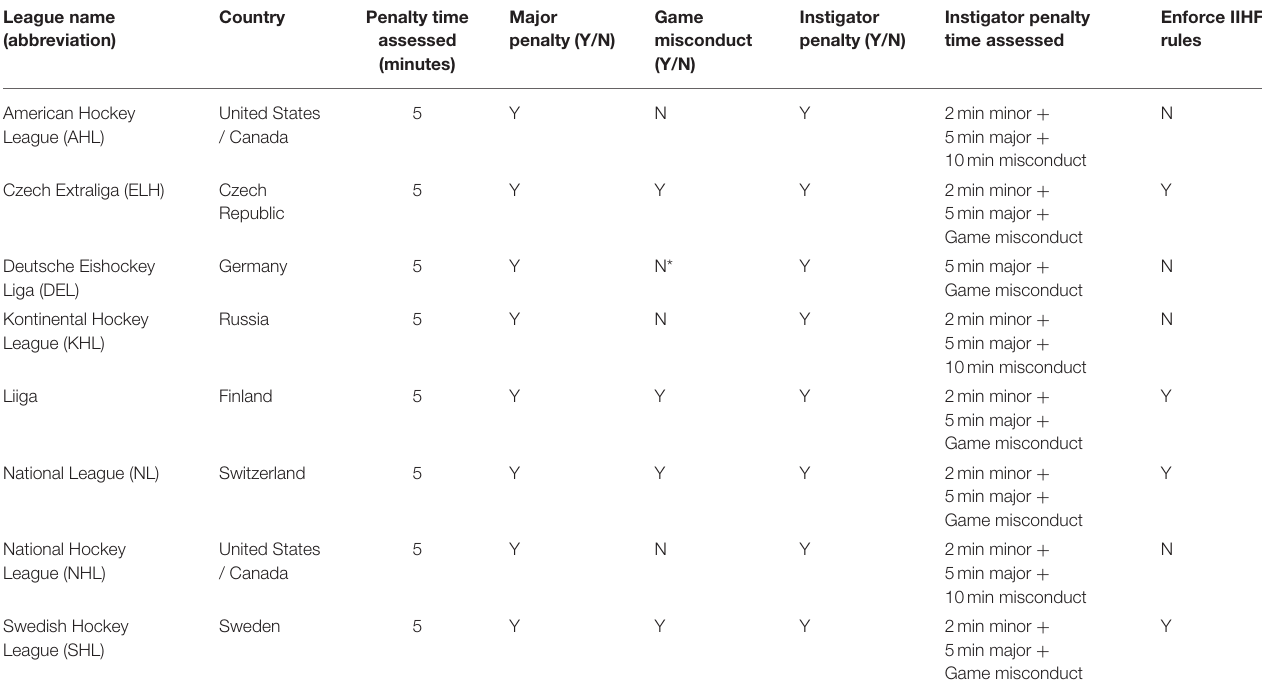
TABLE 2 | Comparison of penalties for fighting among top professional ice hockey leagues in North America and Europe. League name